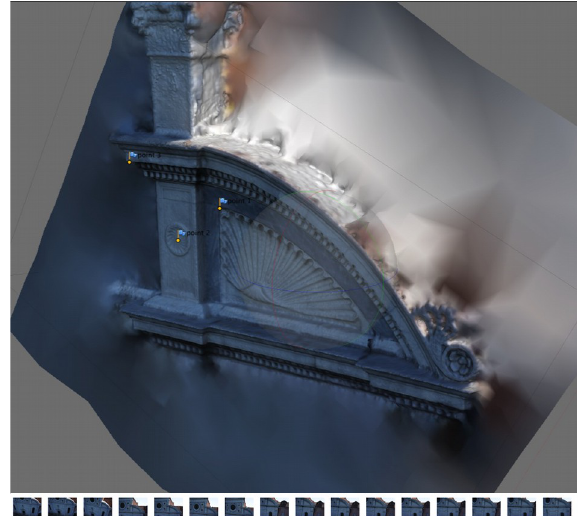
Figure 6. The photogrammetric model of the upper decoration of the facade in Photoscan